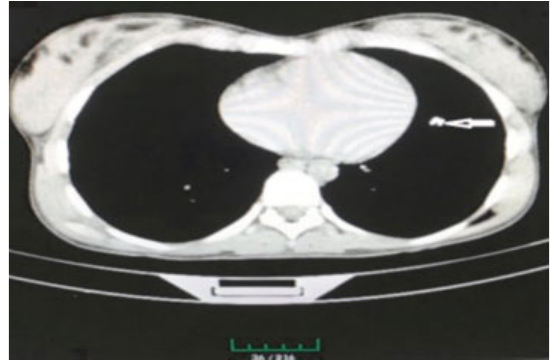
Fig. 2 A computed tomography scan showing two linear hyperdense areas in close vicinity on the left pulmonary parenchyma.